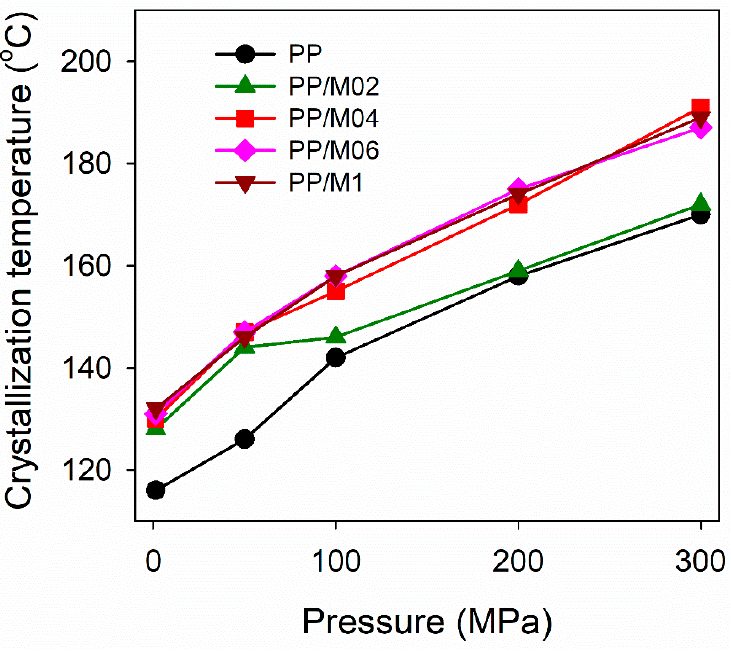
Figure 2. Crystallization temperature of neat and nucleated PP during cooling, according to protocol I, vs. pressure.